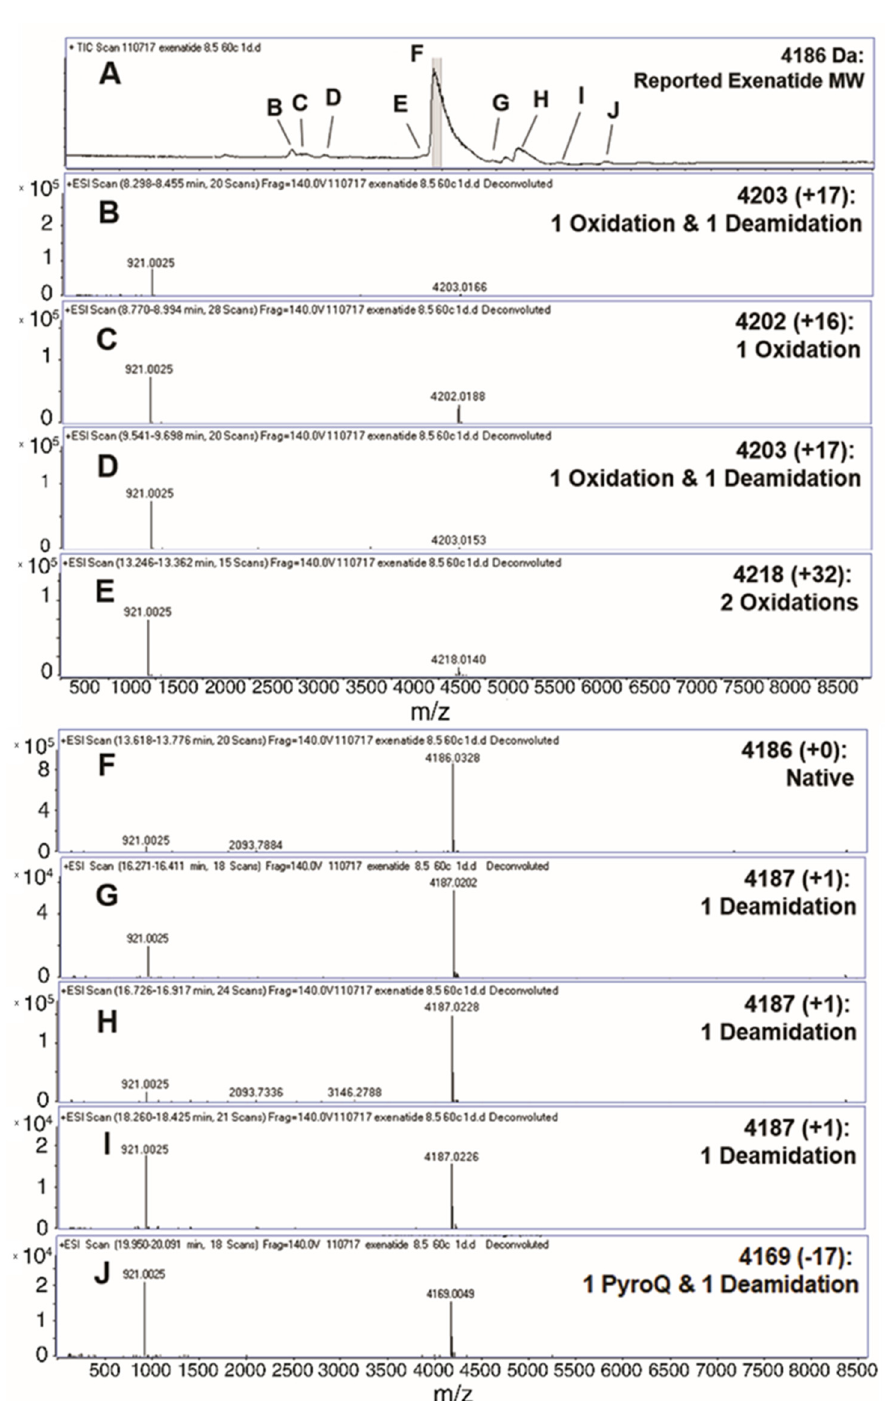
Figure 1. Identification (with deconvoluted masses) of exenatide’s chemical impurities by